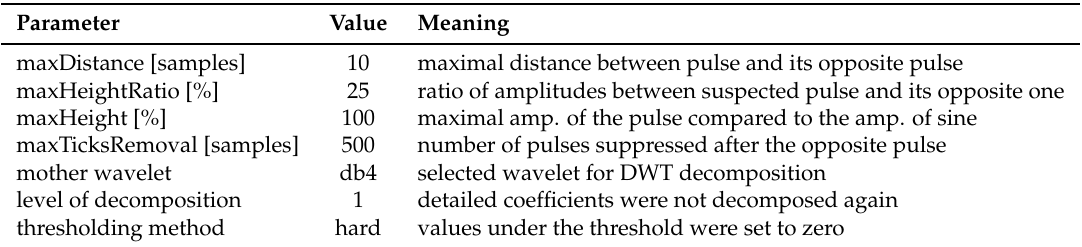
Table 2. Settings applied in denoising and feature extraction from previous study [8]. * IG stands for information gain